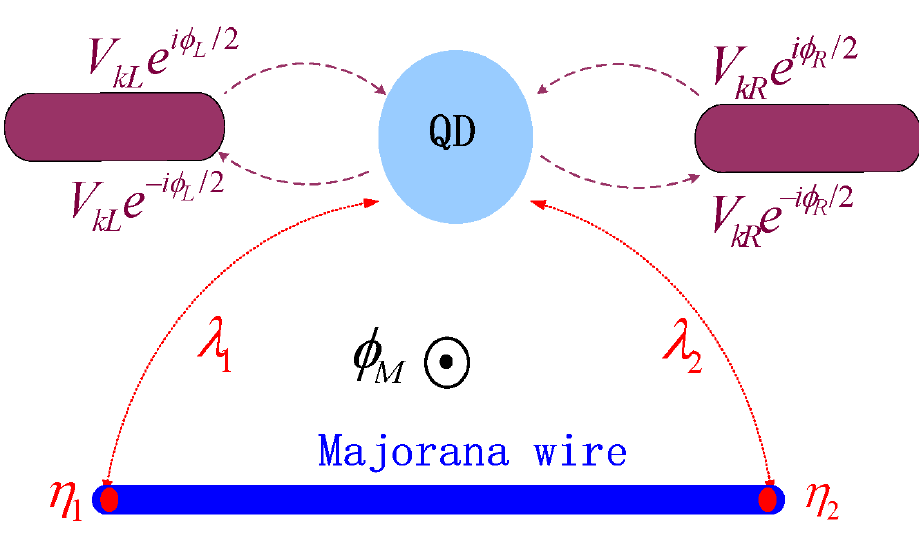
Figure 1. (Color online) Schematic plot of the system composing of a QD connected to superconductor leads and a nanowire hosting Majorana bound states. The dot with discrete energy level ε d is coupled to the leads with strengths of V kL / R and to the MBSs with λ 1/2 . The phase in the two superconductors are denoted by φ L / R whose difference induces the Josephson current. If the dot is coupled simultaneously to both of the two modes of the MBSs, a magnetic flux φ M emerges from the applied magnetic